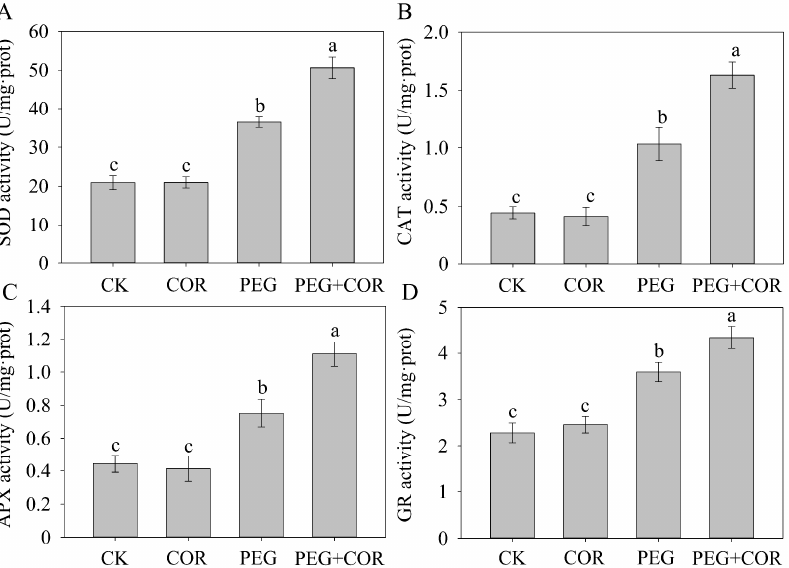
Figure 3. Effect of COR on the activities of superoxide dismutase (SOD) ( A ), catalase (CAT) ( B ), ascorbate peroxidase (APX) ( C ), and glutathione reductase (GR) ( D ) under osmotic conditions. Values with bars are the means ± SDs (n = 5), and different letters indicate significant differences at p < 0.05.